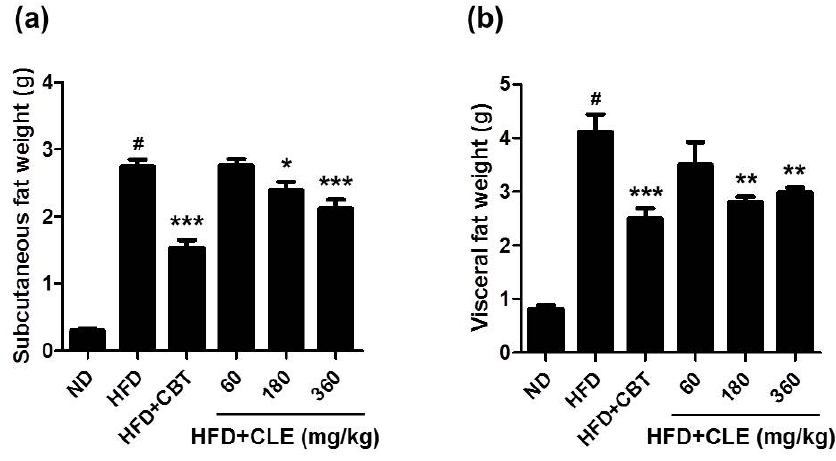
Figure 2. Effect of CLE on adipose tissue weights in HFD-fed mice. ( a ) Effect of CLE on subcutaneous fat weight in HFD-fed mice. ( b ) Effect of CLE on visceral fat weight in HFD-fed mice. Values are the mean ± SEM ( n = 10), # p < 0.05 vs. ND-fed mice, * p < 0.05, ** p < 0.01, *** p < 0.001 vs. HFD-fed mice. ND: normal chow diet, HFD: 60% high fat diet + vehicle, HFD + CBT: 60% high fat diet + reductil (CBT, 2 mg/kg), HFD + CLE: 60% high fat diet + CLE (60, 180 and 360 mg/kg,